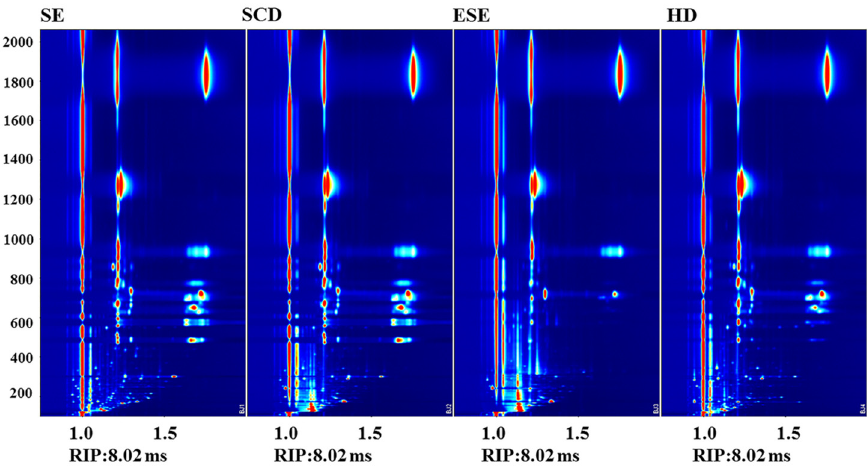
Figure 3. Top view of the GC-IMS 3D topographic map of the SAEOs extracted by different methods. The longitudinal coordinate is the gas phase retention time, and the abscissa is the ion migration time (drift time).